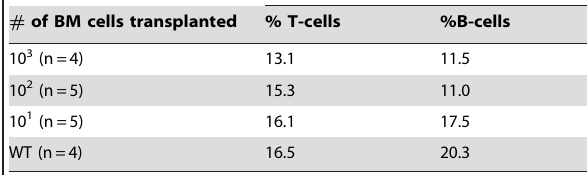
Table 3. Titration of expanded bone marrow cells required for reconstitution of the lymphoid compartment in irradiated Rag-1 2 / 2 mice.